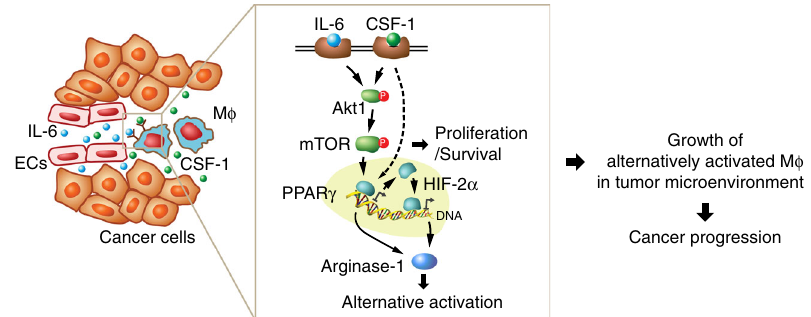
Fig. 9 A schematic model. In glioma microenvironment, endothelial cell-derived IL-6 and microenvironmental CSF-1 synergistically activate downstream Akt1/mTOR pathway and induces transcriptional activation of PPAR γ in macrophages (M ϕ ), in turn leading to HIF-2 α -mediated arginase-1 expression, and inducing macrophage alternative polarization. The activation of mTOR also induces cell proliferation, contributing to cell survival and growth of alternatively activated macrophages, eventually leading to